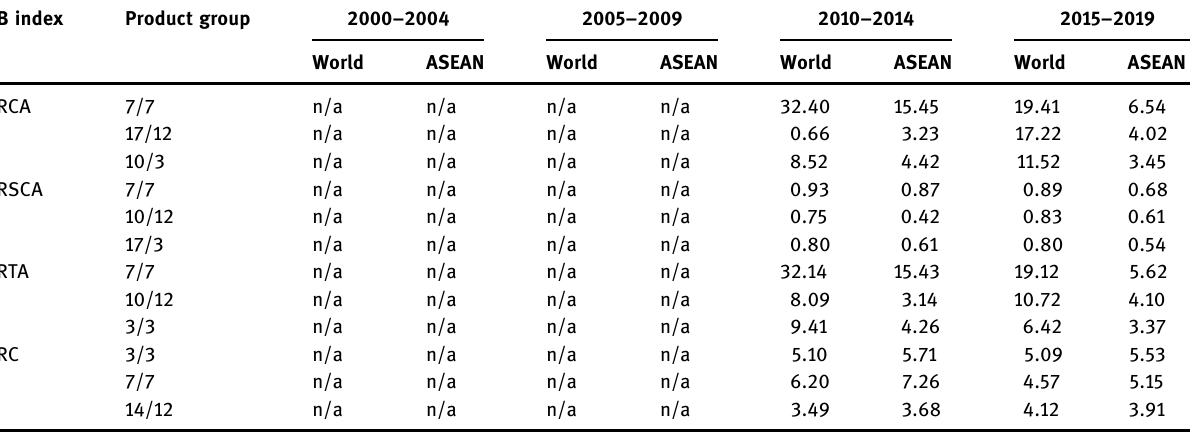
Table 9: The three highest Balassa indices of Myanmar at World and ASEAN level, 2000 –